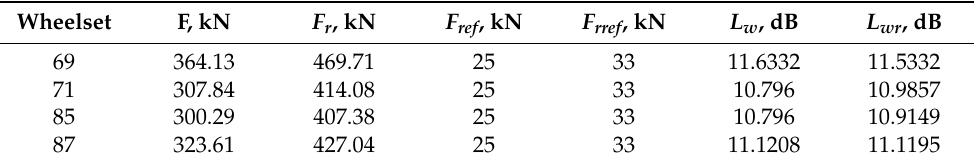
Table 4. Sound power change calculation results are theoretical, at different forces F , F r , F ref and F rref , and sound force change parameters L w and L wr